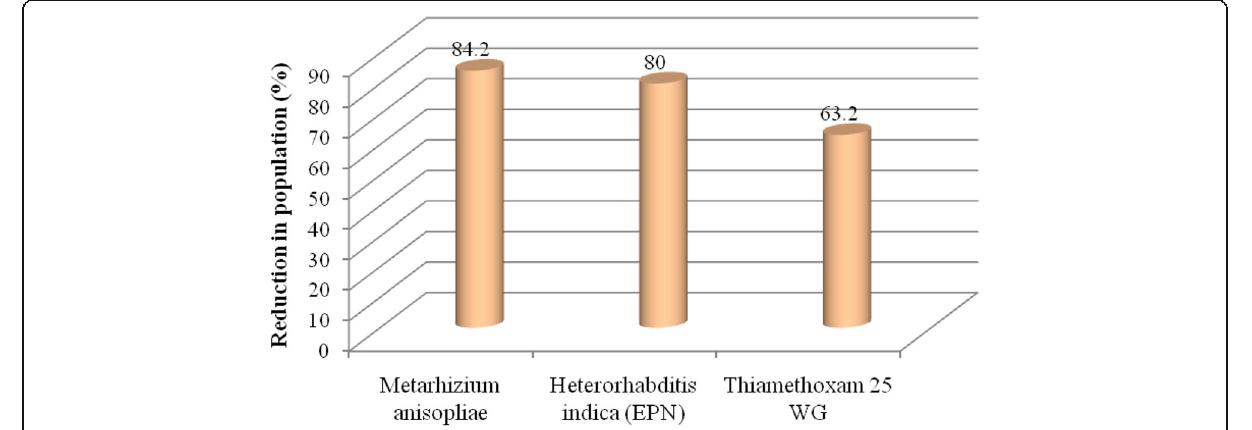
Fig. 6 In vivo bioefficacy of Metarhizium anisopliae against